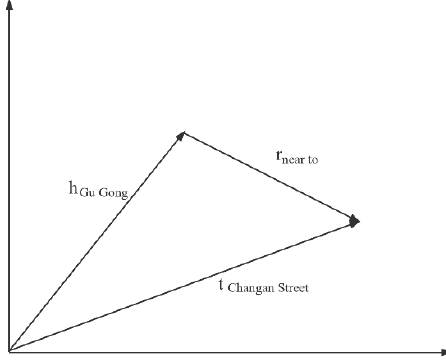
Figure 5 . Representation of UHB knowledge in TransE Where ℎ 𝐺𝑢 𝐺𝑜𝑛𝑔 represents 'Gu Gong'; 𝑡 𝐶ℎ𝑎𝑛𝑔𝑎𝑛 𝑆𝑡𝑟𝑒𝑒𝑡 represents 'Changan Street'; 𝑟 𝑛𝑒𝑎𝑟 𝑡𝑜 represents the semantic relationship between